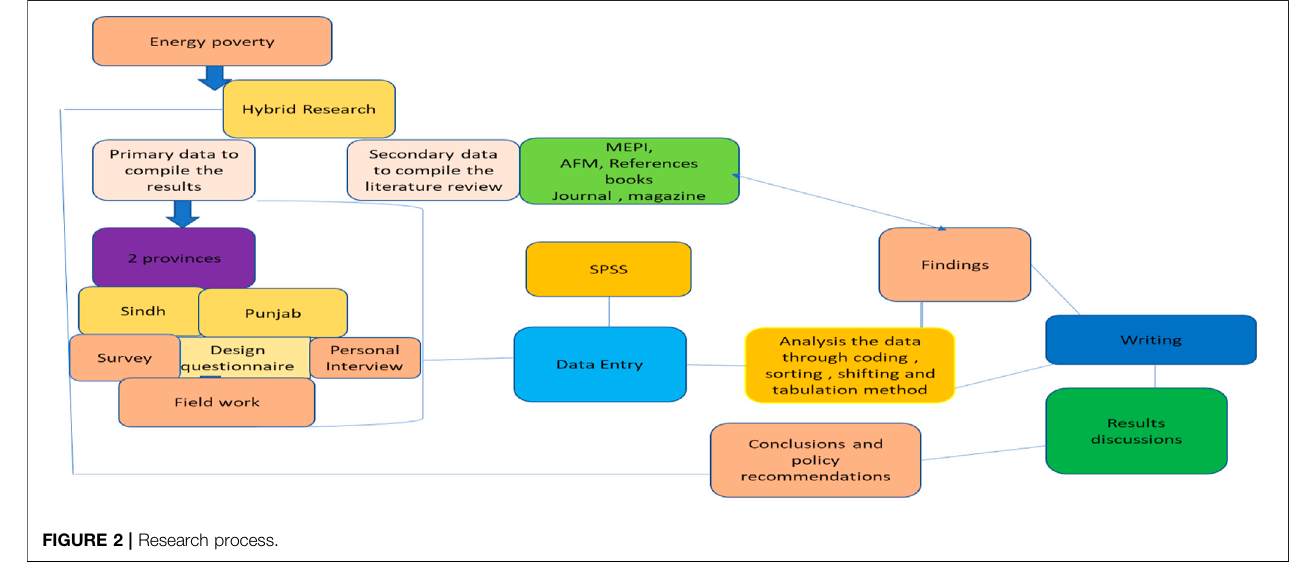
FIGURE 2 | Research process.